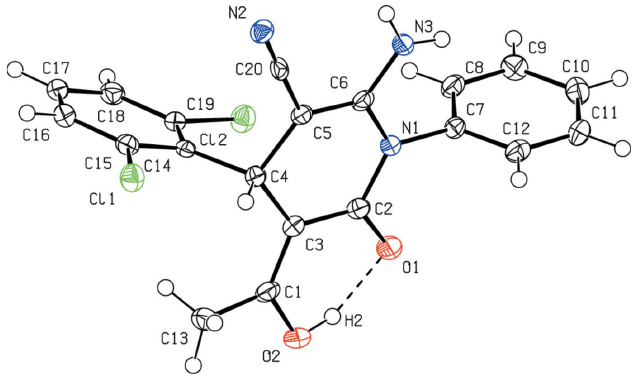
Figure 1 The molecular structure of the title compound showing the atom- numbering scheme and displacement ellipsoids at the 50% probability level.